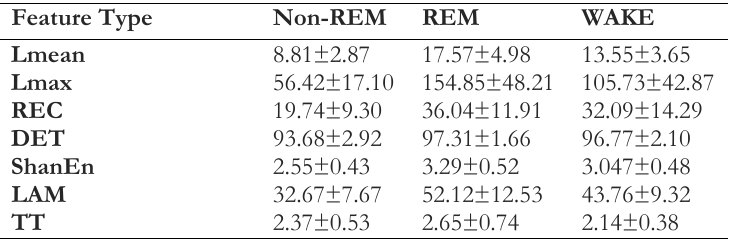
Table 3. The mean and standard deviation of nonlinear features at the first four stages of